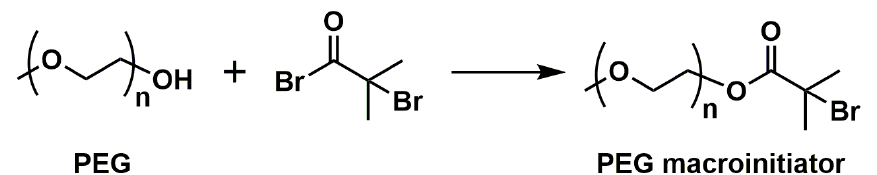
Figure 3. A typical synthesis of PEG macroinitiator of ATRP for amphiphilic block